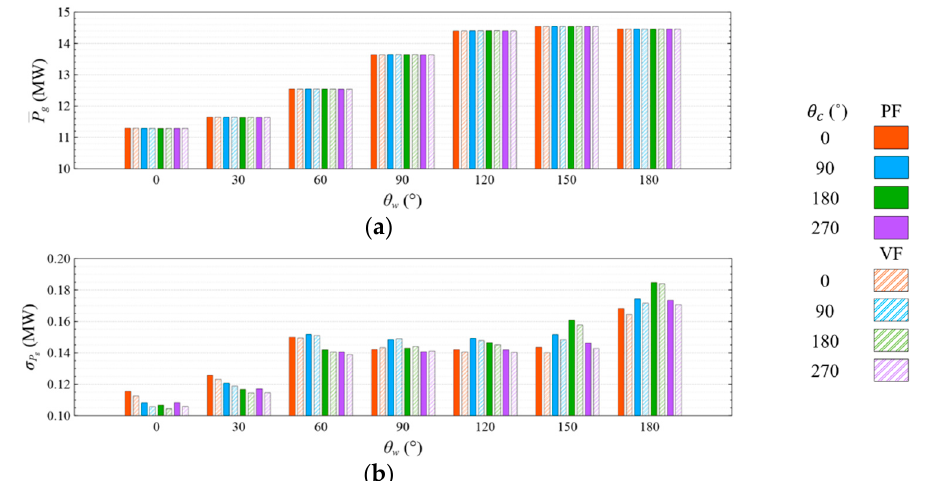
Figure 20. Comparison of ( a ) means and ( b ) standard deviations of generator electrical power under CW condition. CW